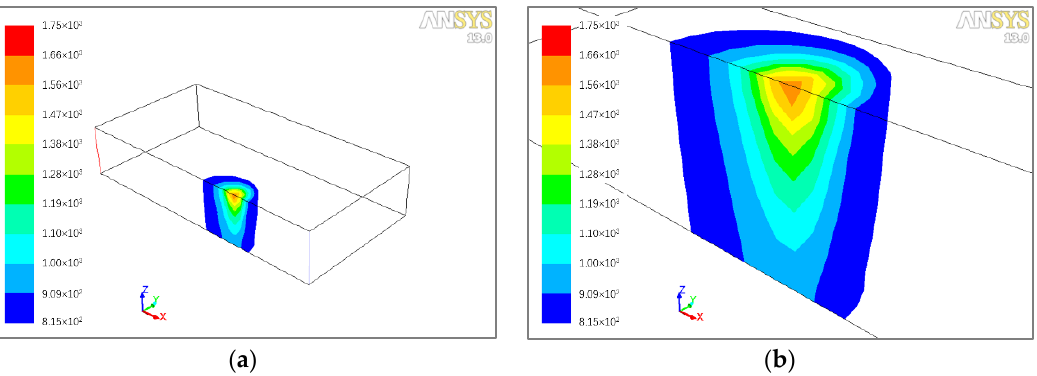
Figure 5. Shape and dimensions of the weld pool for flat welding (at finish point): ( a ) whole model; and ( b ) magnified melt pool region.